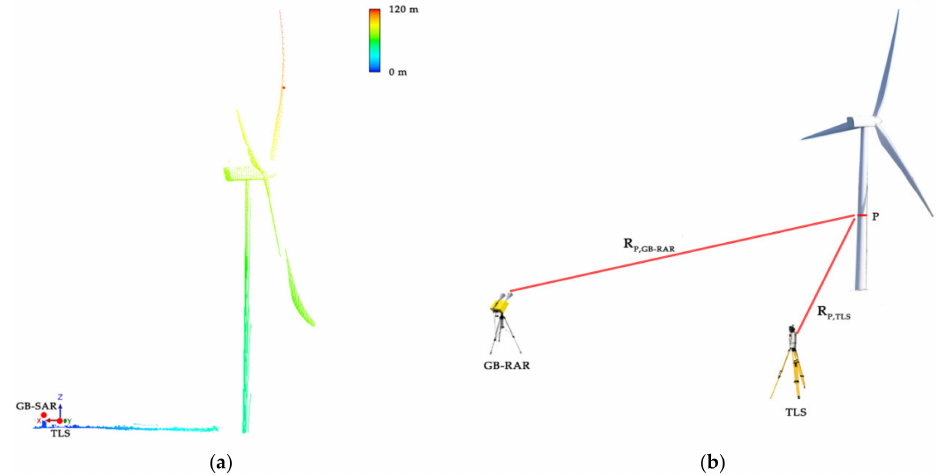
Figure 3. 3D digital surface model of the wind tower ( a ); The distances RP, GB-RAR and RP, TLS of point P on the tower with respect to TLS and GB-RAR ( b